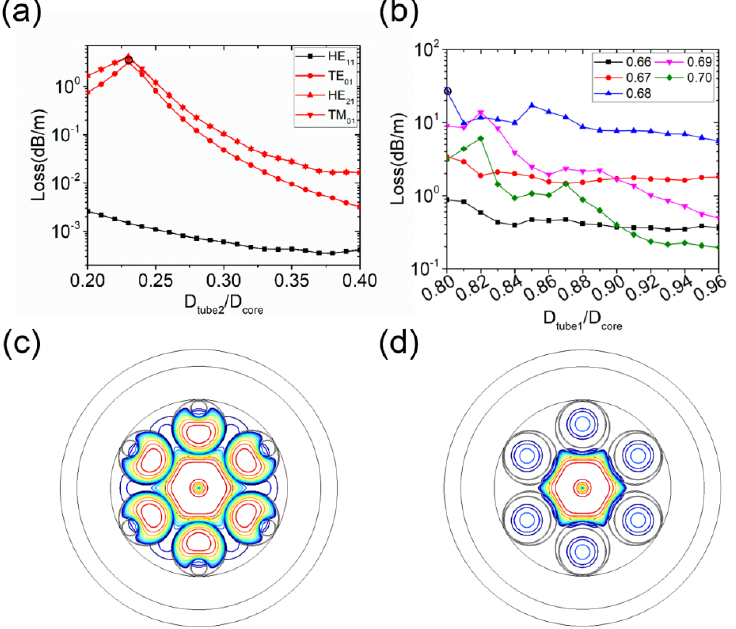
Figure 5. ( a ) The loss of LP 11 modes as a function of D tube2 / D core in an NANF with six nested tubes when the first cladding tube diameter is fixed at D tube1 = 0.80 D core ; ( b ) the loss of the LP 11 (TE 01 ) mode as a function of D tube1 / D core in an NANF with six nested tubes when the first cladding tube diameter is fixed at D tube2 / D core = 0.66, 0.67, 0.68, 0.69, and 0.70; ( c ) 3-dB contour lines of the high-loss LP 11